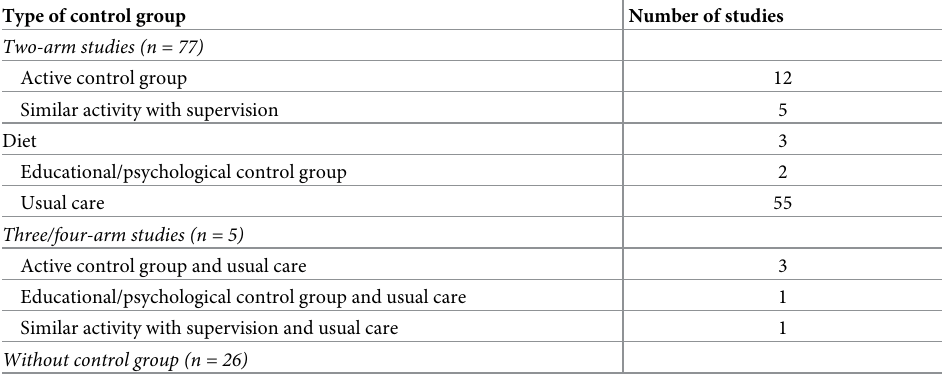
flexibility, and balance exercises), and multidimensional programs (combining PA with nutri- tional or psychological interventions). Complex decongestive therapy and upper limb exercises were specific interventions for treating lymphedema. Finally, a minority of studies offered BCS mind-body practices such as Yoga, Tai Chi, or Qigong, or the performance of resistance Table 3. Characteristics of self-managed interventions, reported in terms of type of activity, duration, recom- mended frequency, and professional managing the program. Characteristics of the interventions Number of interventions (n = 108) Type of activity Aerobic exercise program 39 Resistance exercise program 6 Combined exercise program (aerobic, resistance, stretching, flexibility) 25 Mind-body practice (Yoga, Tai Chi, Qigong) 11 Multidimensional program (physical, nutritional, psychological) 12 Complex decongestive therapy 12 Upper limb exercise program 3 Duration 1–2 months 30 3–5 months 31 6–11 months 32 � 1 year 15 Frequency 1–2 times / week 11 � 3 times / week 57 Daily 22 Not indicated 18 Responsible professional Exercise expert 25 Physiotherapist 21 Multidisciplinary team 12 Nurse 11 Mind-body teacher 8 Others 2 Not specified